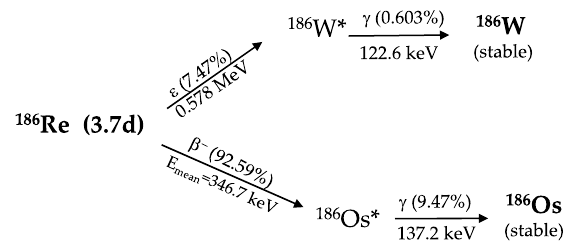
Figure 1. 186 Re simplified decay scheme.